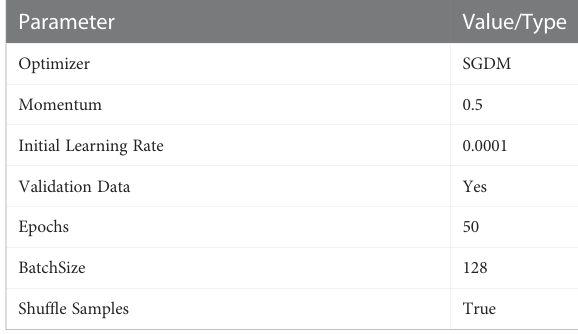
TABLE 4 List of hyper parameters used for training CANet CNN model for plant leaf disease subtype classi fi